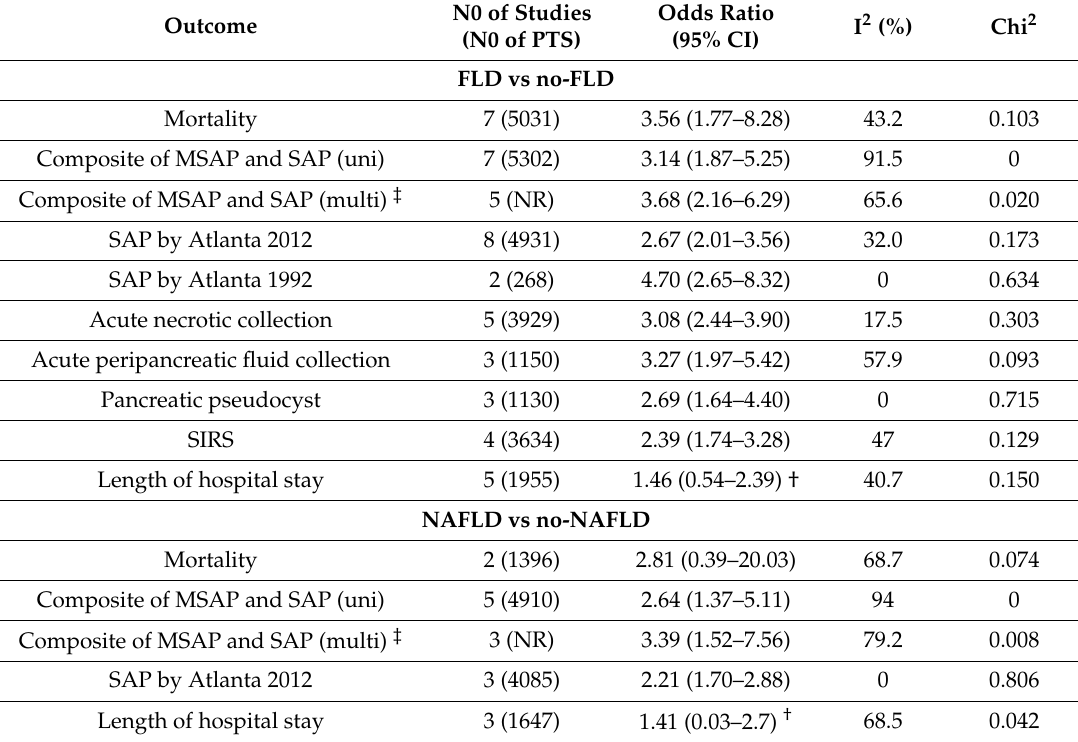
Table 2. Summary of